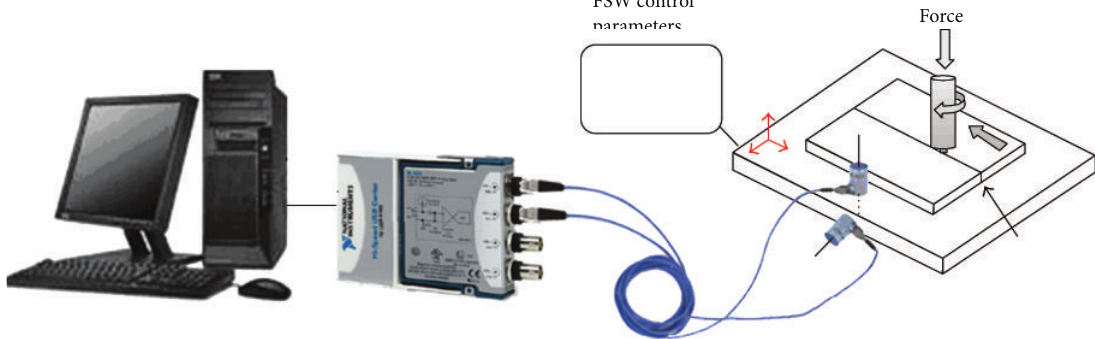
Figure 1: Schematic diagram of the experimental